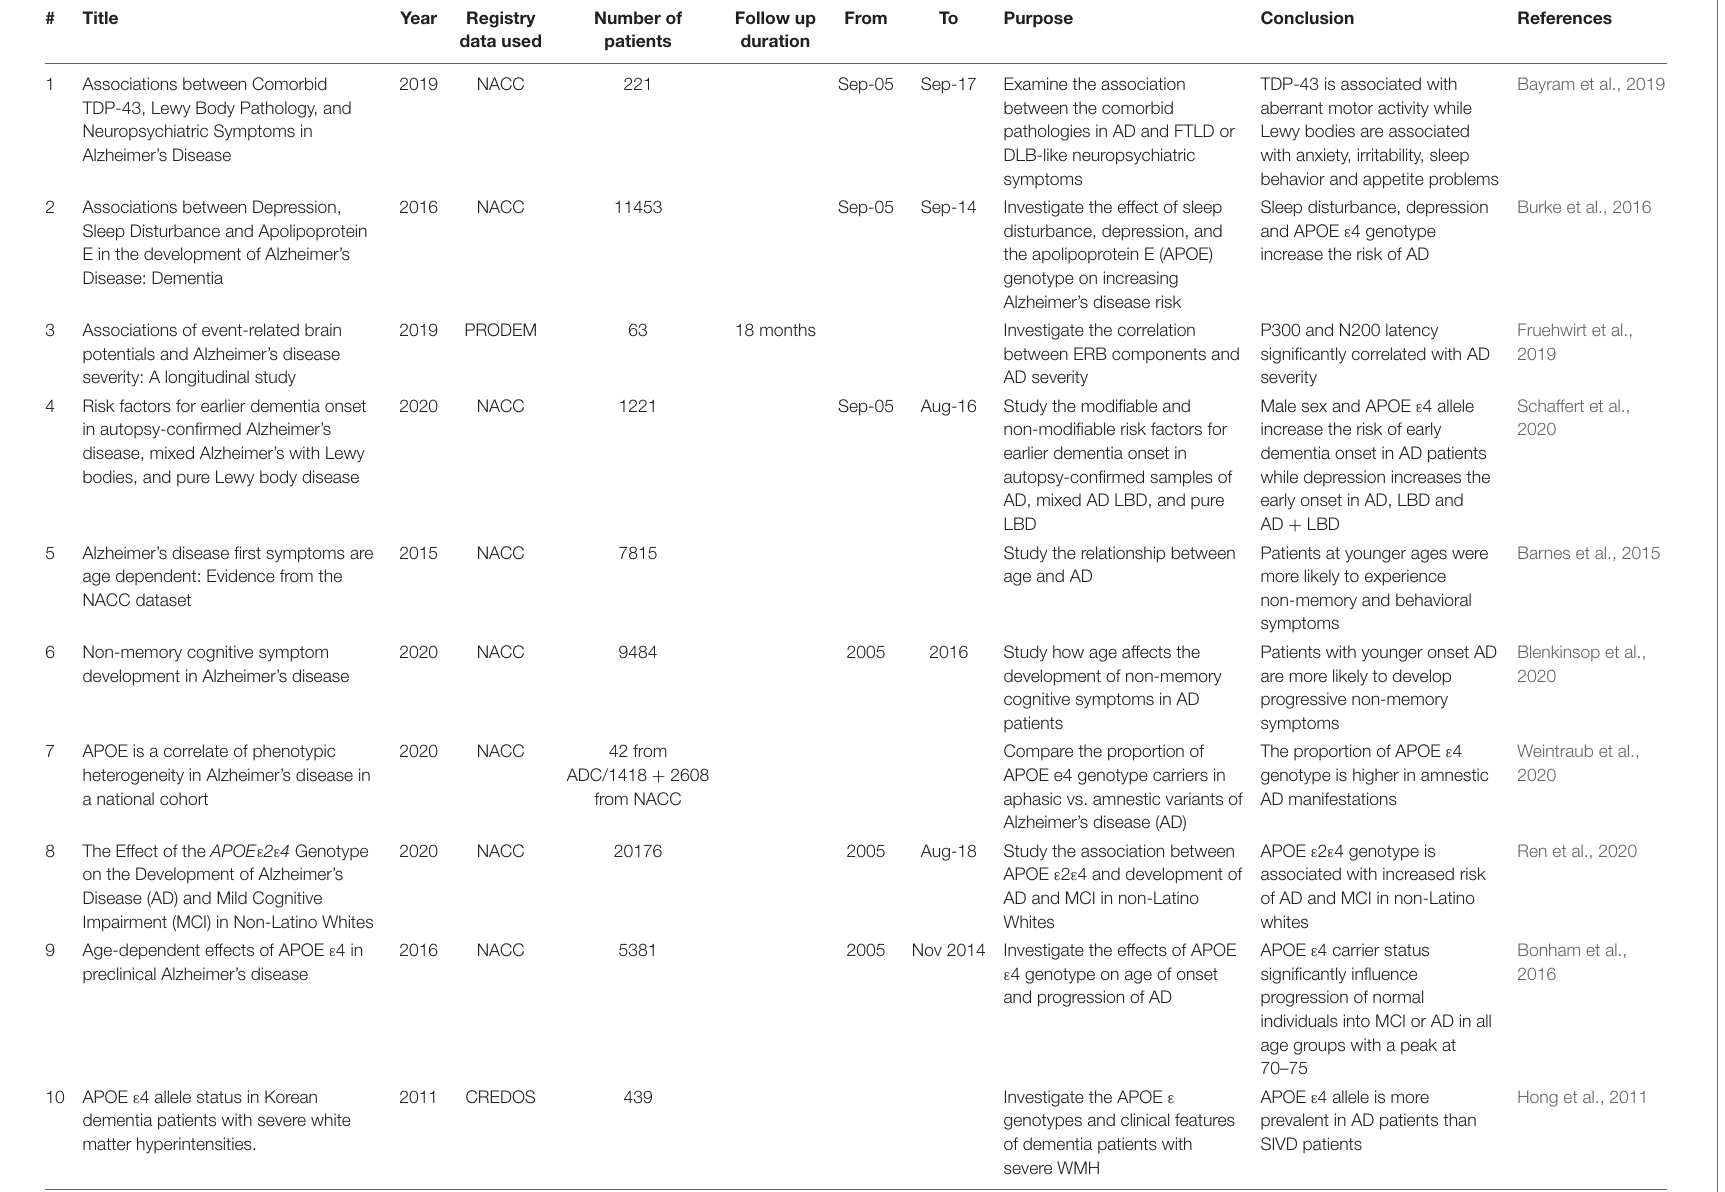
TABLE 3 | Registry-based studies on dementia diagnostics and risk factors.